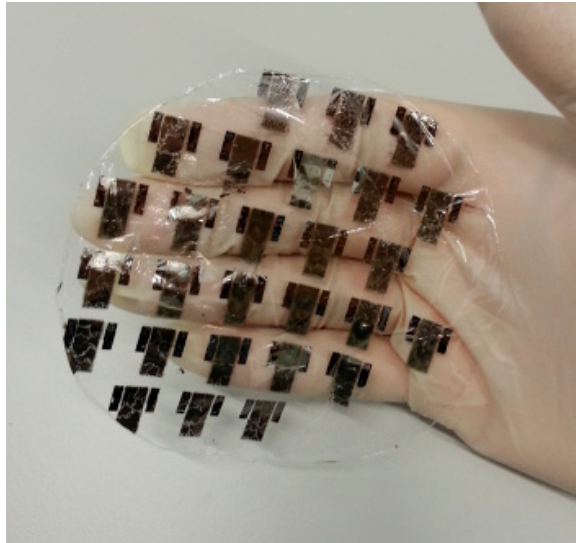
Figure 10. Array of organic field-effect transistors fabricated on PLA [168]. Reprinted with permission from ref. [165]. Copyright 2014 Elsevier